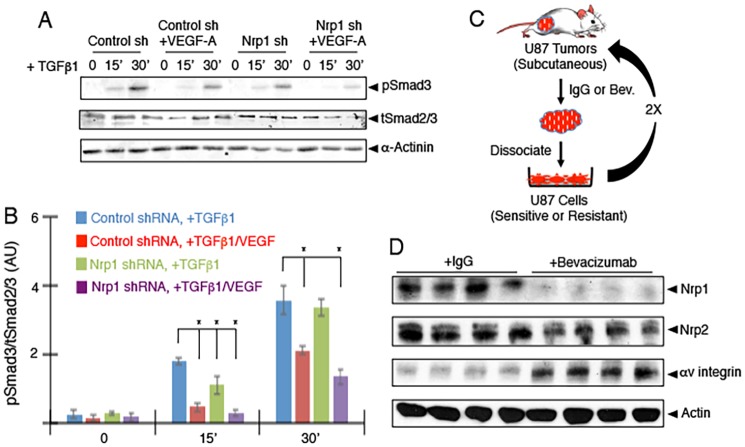
VEGF-A competitively inhibits Nrp1-mediated canonical TGFβ receptor signaling in GBM cells.(A); LN229 cells were treated with 1 ng/ml TGFβ1 for varying times in the presence or absence of 100 ng/ml VEGF-A. Detergent-soluble lysates were immunoblotted with anti-pSmad3 antibodies to access Nrp1-dependent canonical TGFβ signaling. Note that VEGF-A competitively inhibits TGFβ-mediated Smad3 phosphorylation in control cells, and these effects are enhanced in LN229 cells expressing Nrp1 shRNAs. (B); Quantitation of Nrp1-dependent Smad3 phosphorylation levels in response to TGFβ1 and VEGF-A treatment of LN229 cells. Error bars represent standard deviation, *p<0.05 for control shRNA/+TGFβ1 versus other treatments at 15 minutes and *p<0.05 for control shRNA/+TGFβ1 versus Nrp1 shRNA/+TGFβ1 and Nrp1 shRNA/+TGFβ1/VEGF-A treatments at 30 minutes. All error bars represent standard deviation. (C); Diagram showing the experimental strategy to generate drug-resistant U87 GBM cells by selecting for tumor growth in mice followed by bevacizumab treatment. (D); bevacizumab-sensitive (U87-bevS, n = 4) and bevacizumab-resistant (U87-bevR, n = 4) tumor lysates were immunoblotted with human-specific antibodies directed against Nrp1, Nrp2, or αv integrin proteins. Note that Nrp1 protein levels are diminished in U87-bevR tumors, whereas αv integrin levels are increased and Nrp2 levels are unchanged.